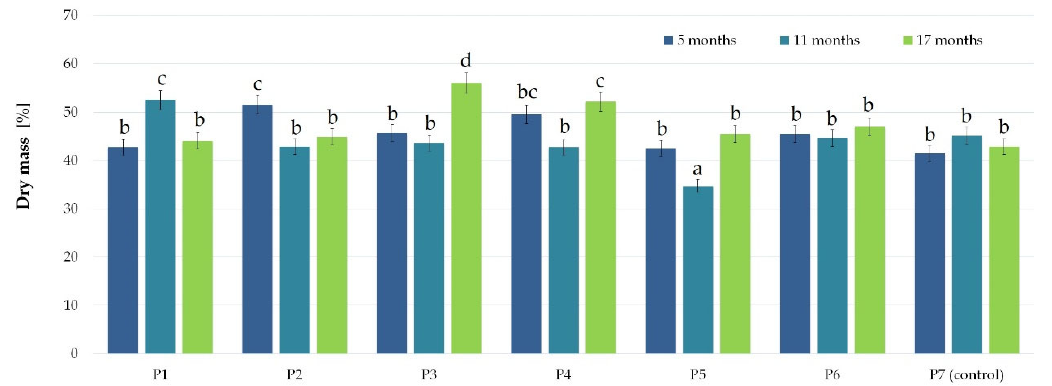
Figure 4. Silage dry mass [%] changes during bale storage for 5, 11 and 17 months. Bars marked with the same letters indicate no statistical difference ( p < 0.05). Table 2. Silage parameters (the average content in DM). Values marked with the same letters indi ‐ cate no statistical difference ( p < 0.05); results were analyzed separately for each parameter.